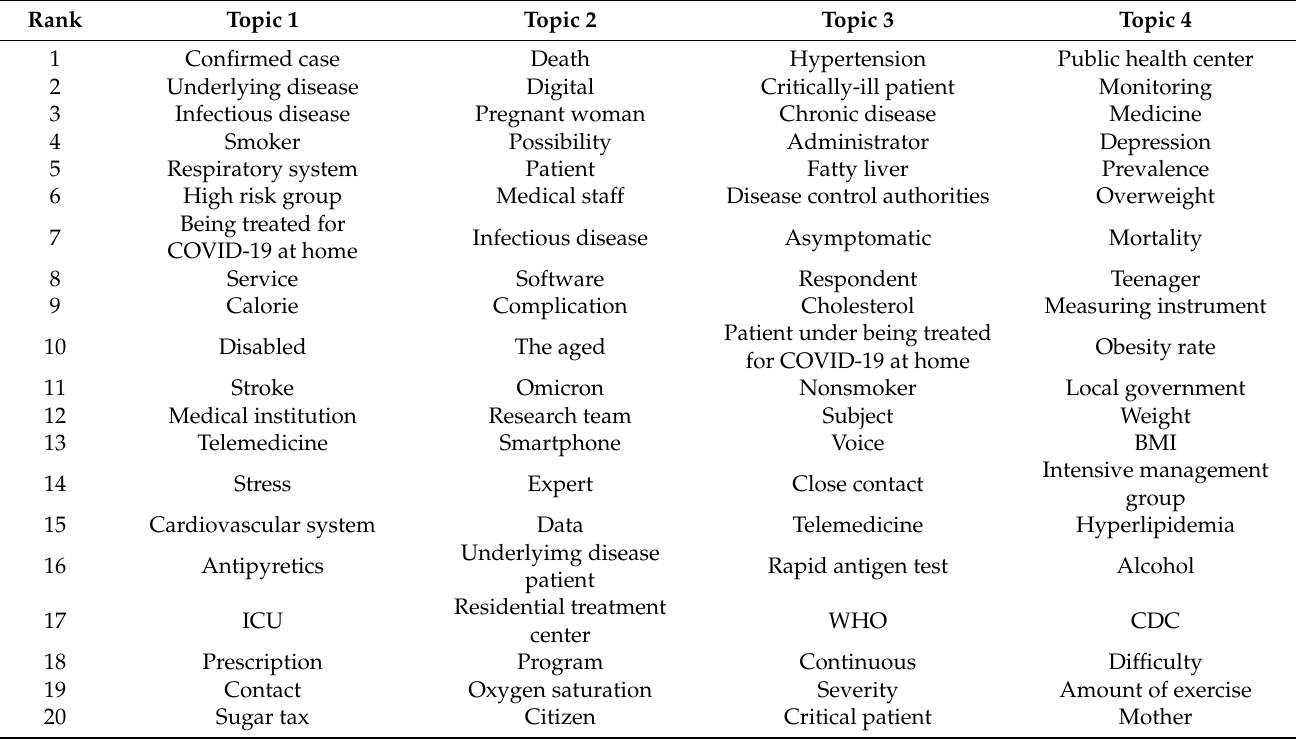
Figure 1. Results of LDA topic modeling ‘Topic 1’ in people with diabetes during the COVID-19 [12,13]. Table 2. Results of LDA Topic Modeling on People with diabetes during COVID-19.